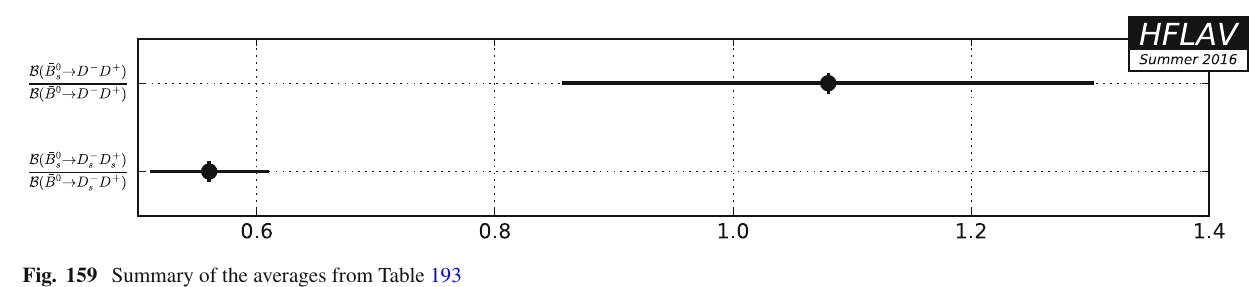
Fig. 158 Summary of the averages from Table 192